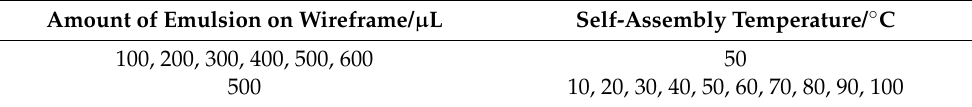
Table 2. Single-factor variables of self-assembly of P(St-AA) microspheres on a wood surface. Amount of Emulsion on Wireframe/ µ